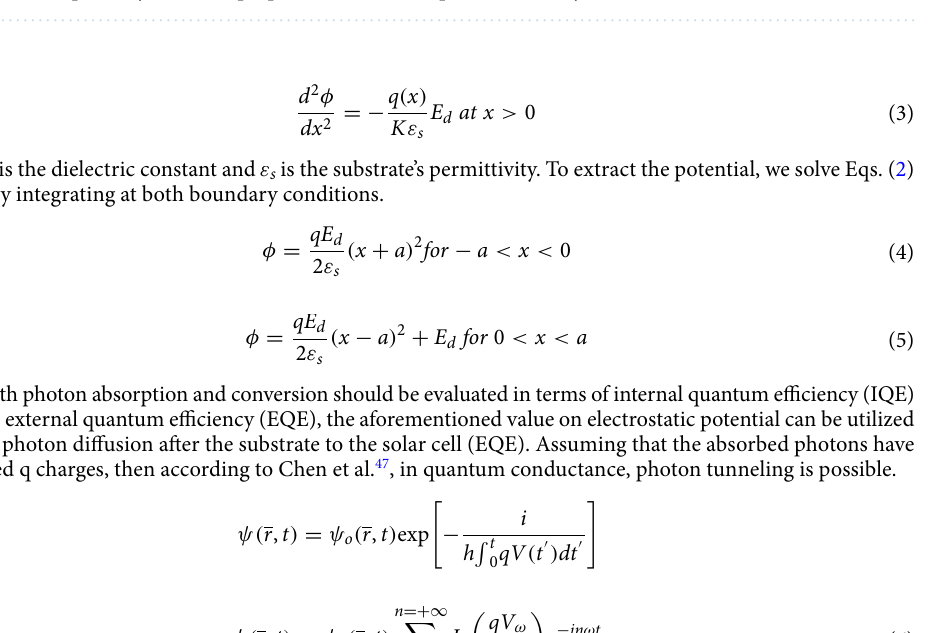
Figure 3. Conceptual layout of the proposed absorber for photon mobility